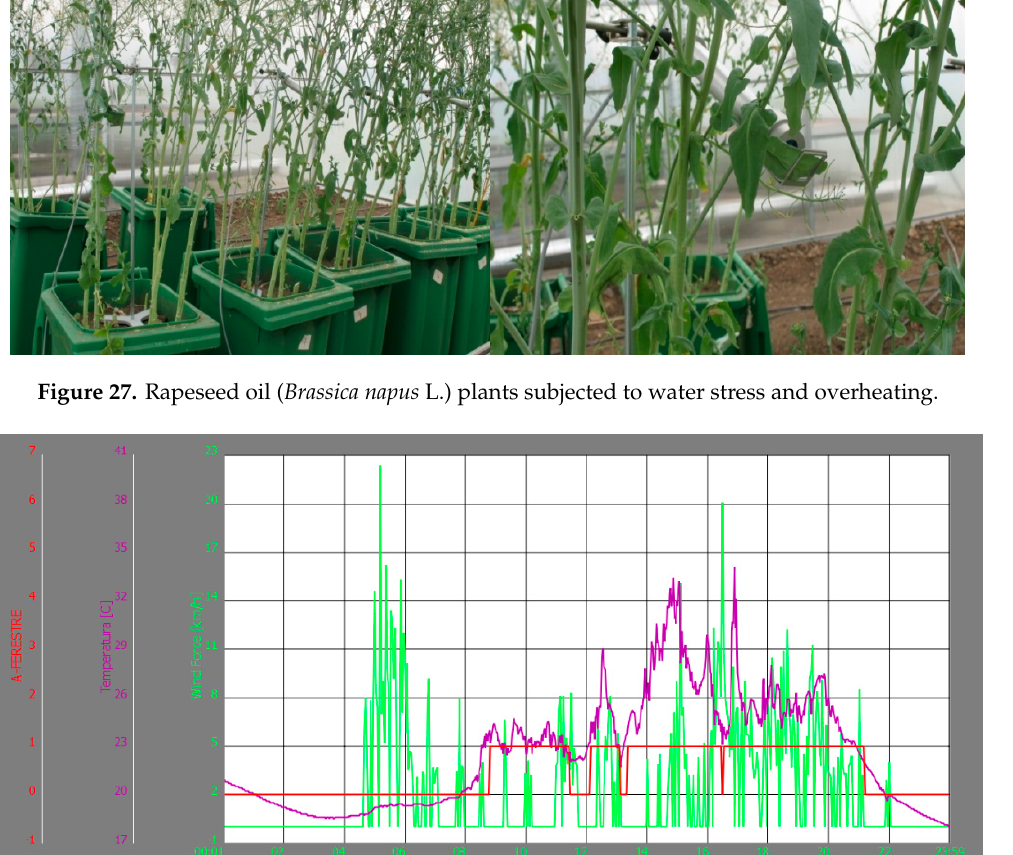
Figure 28. Window control based on internal temperature and wind speed bounds.